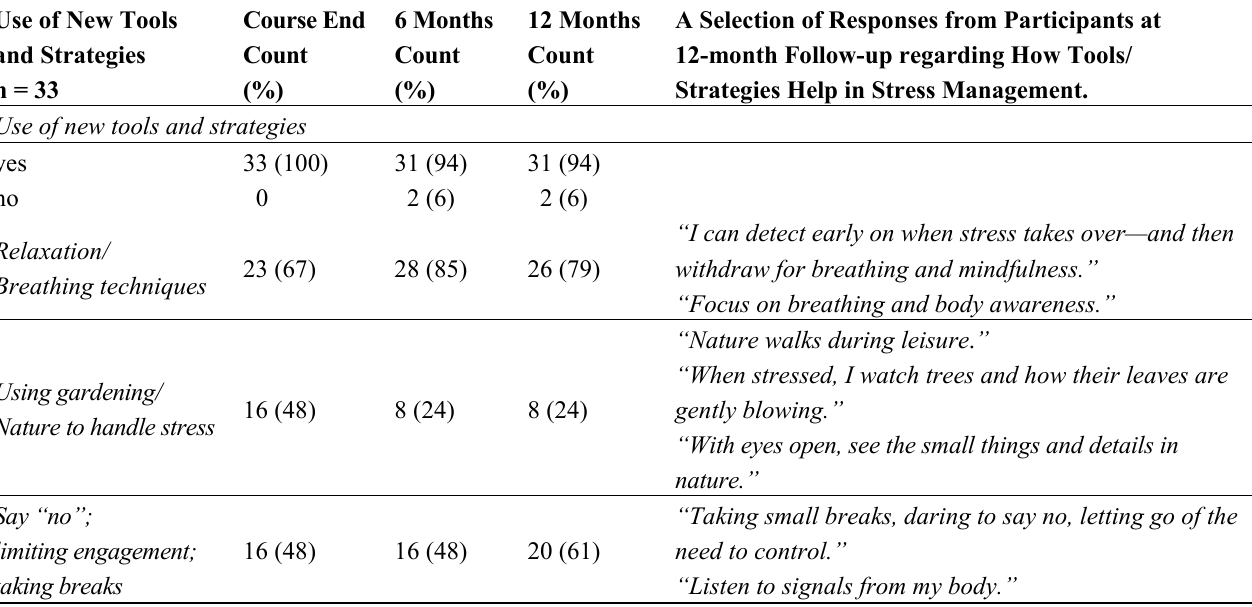
Table 7. Participants’ use of new tools and strategies for stress management at course end and at the 6- and 12-month follow-up. An unlimited number of responses was possible for this open-ended